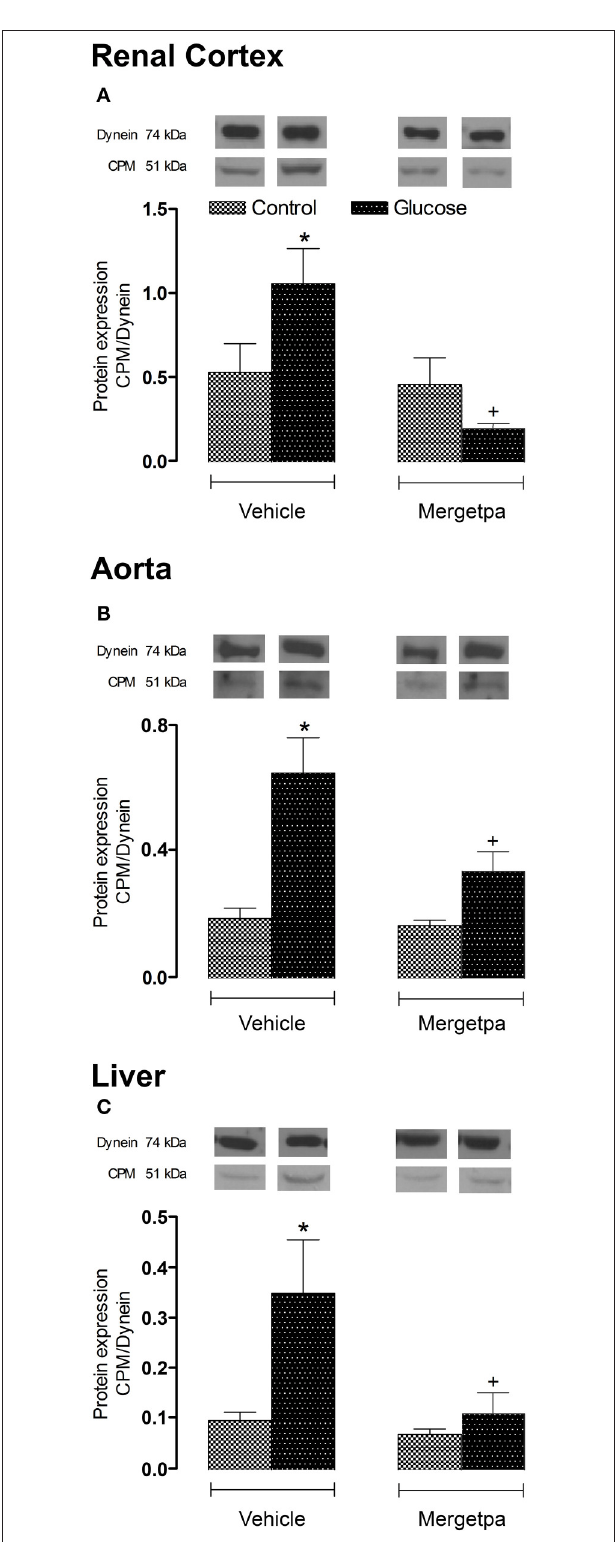
FIGURE 5 | Treatment effect on CPM expression. Effect of s.c. administered Mergetpa (1 mg.kg − 1 twice daily) for 7 days on CPM expression in (A)